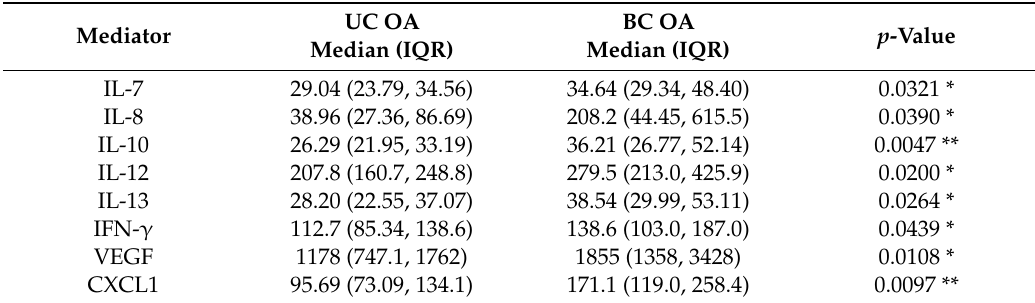
Table 3. Di ff erent cytokine patterns in UC and BC